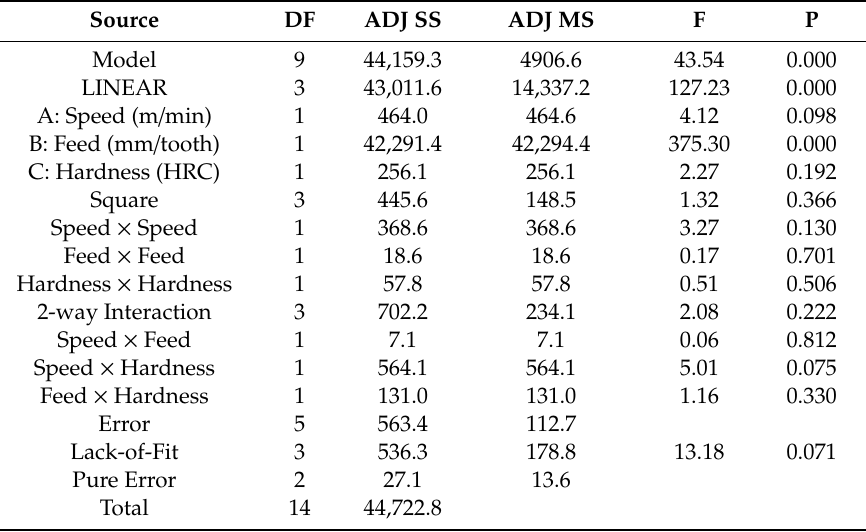
Table 7. ANOVA for full quadratic equation.